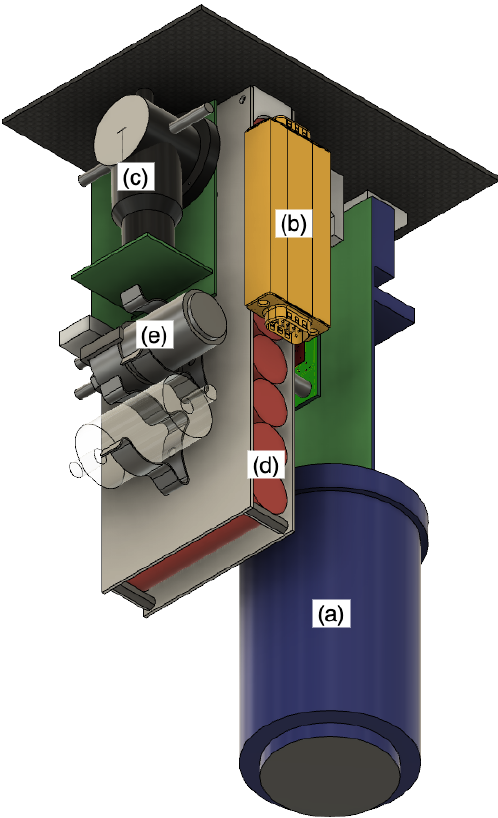
Figure 3. Rendering of RACHuTS profiler. The FLASH-B water vapor sensor ( a , blue), TSEN pressure sensor and electronics ( b , yellow), and ROPC aerosol and cloud particle detector ( c , black and green) are visible. Other components include the lithium-ion battery pack ( d , red) and the ROPC pump ( e , silver). The TSEN temper- ature sensor and main control board are not visible. The thermal housing and docking connector are omitted for